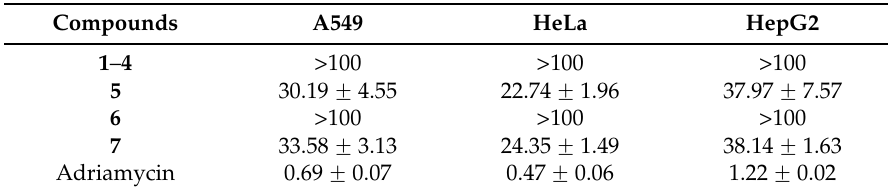
Table 3. Cytotoxicity of compounds 1 – 7 (IC 50 , µ M).